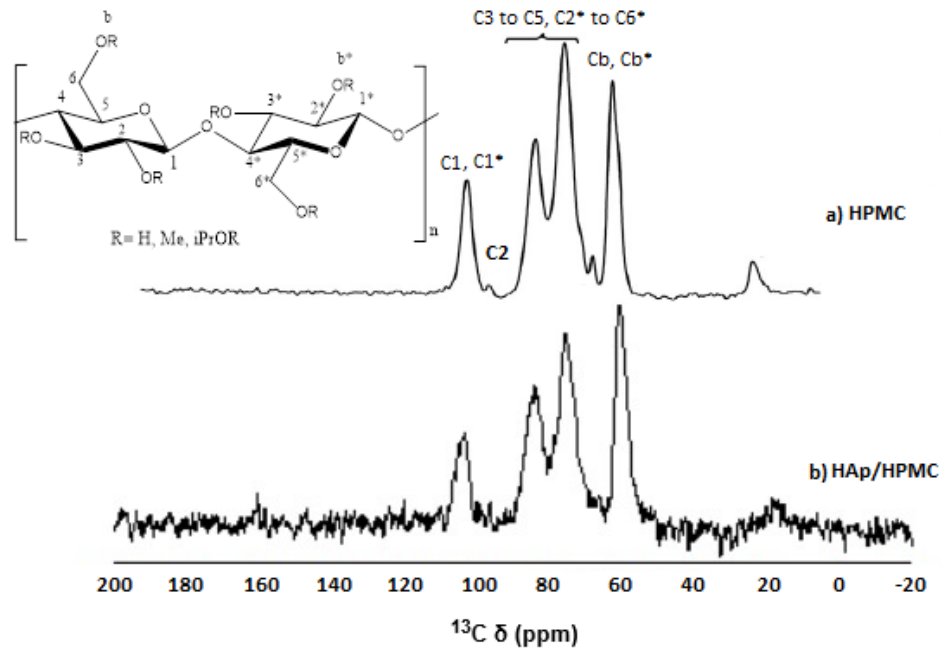
Figure 5. 13 C CP-MAS solid- state NMR spectra ( a ) HPMC ( b ) HAp/HPMC. In the spectrum of HAp/HPMC grafted film, the resonance peak due to C-band Cb*